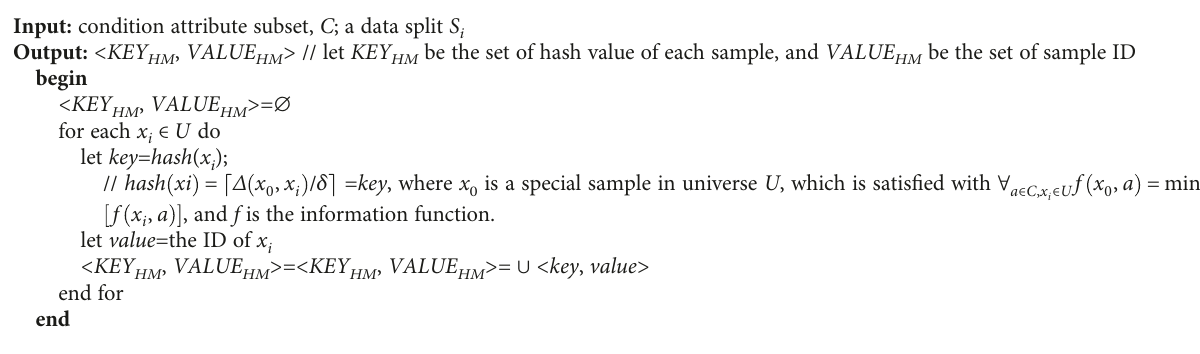
Algorithm 1: Hash-Map function.